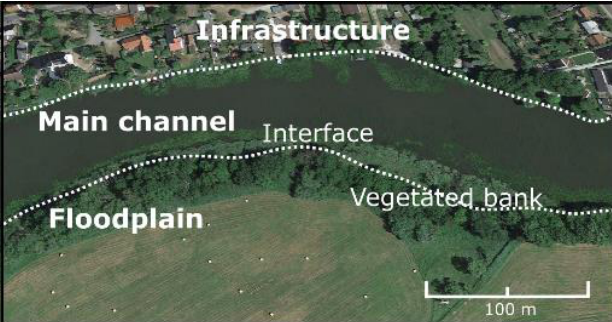
Figure 1. An example of a partly vegetated channel showing the interface between the main channel and floodplain. Vegetation on the banks controls the lateral sediment transport from the main channel onto the floodplain. Source: Google Earth (6 June 2018).